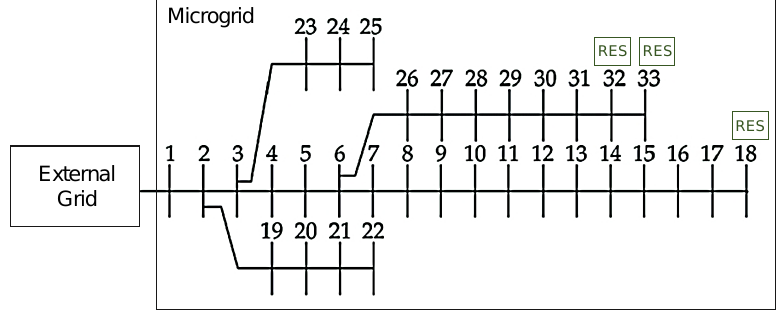
Figure 5. Microgrid test system installed at each of the four selected